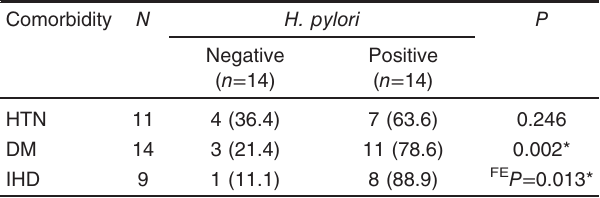
Table 6 Relation between Helicobacter pylori and